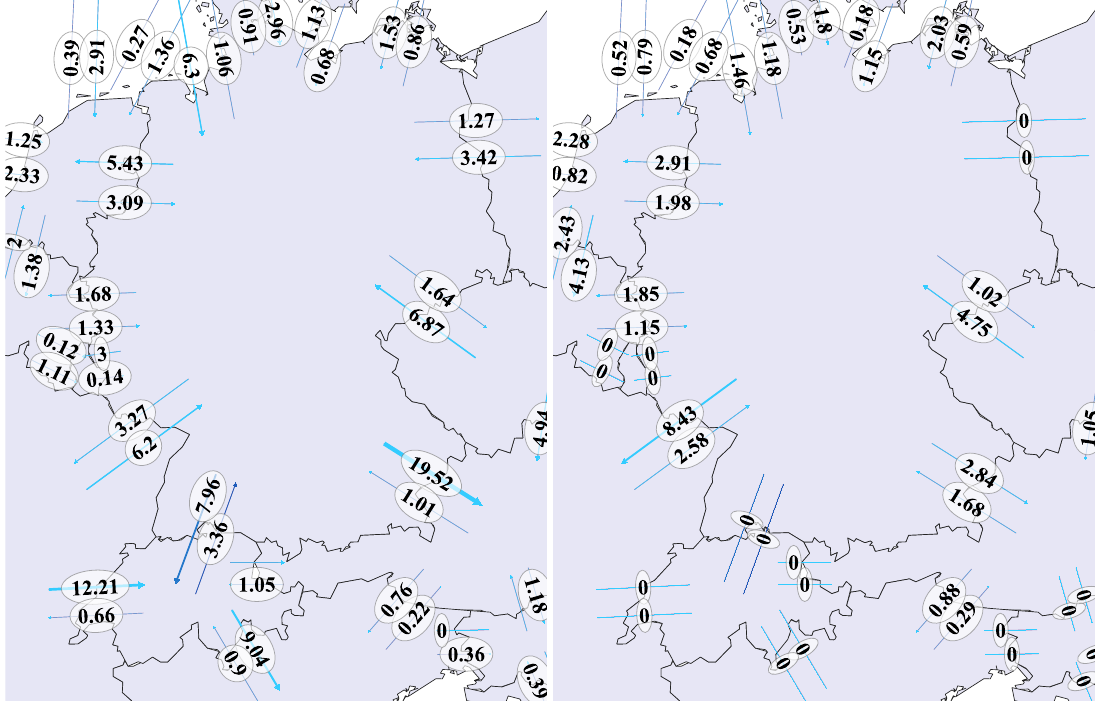
Figure 14. Cumulative annual CB trading volumes on DA ( left ) and ID ( right ) market in [TWh] between Germany and neighboring markets for scenario